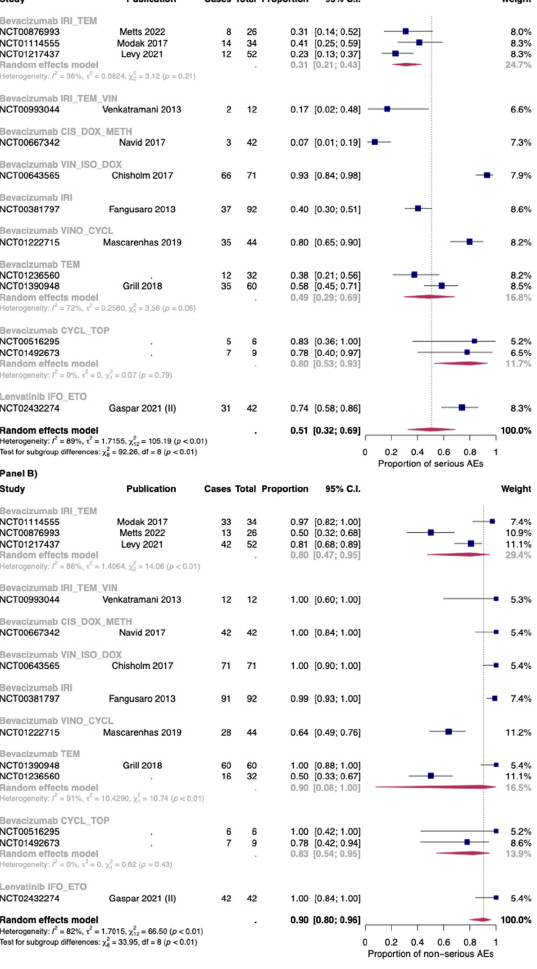
Figure 6. Proportion of serious (Panel A ) and non-serious AEs (Panel B ) for bevacizumab and lenvatinib plus chemotherapy by single regimens; IRI_TEM: Irinotecan + temozolomide; IRI_TEM_VIN: Irinotecan + temozolomide + vincristine; CIS_DOX_METH: Cisplatin + doxorubicin + methotrexate; VIN_ISO_DOX: Vincristine + ifosfamide +doxorubicin; IRI: irinotecan; VINO_CYCL: Vinorelbine + cyclophosphamide; TEM: Temozolomide; CYCL_TOP: Cyclophos- phamide + topotecan; IFO_ETO: Ifosfamide + etoposide. Cases: Patients with at least an event. Total: Patients included in the study